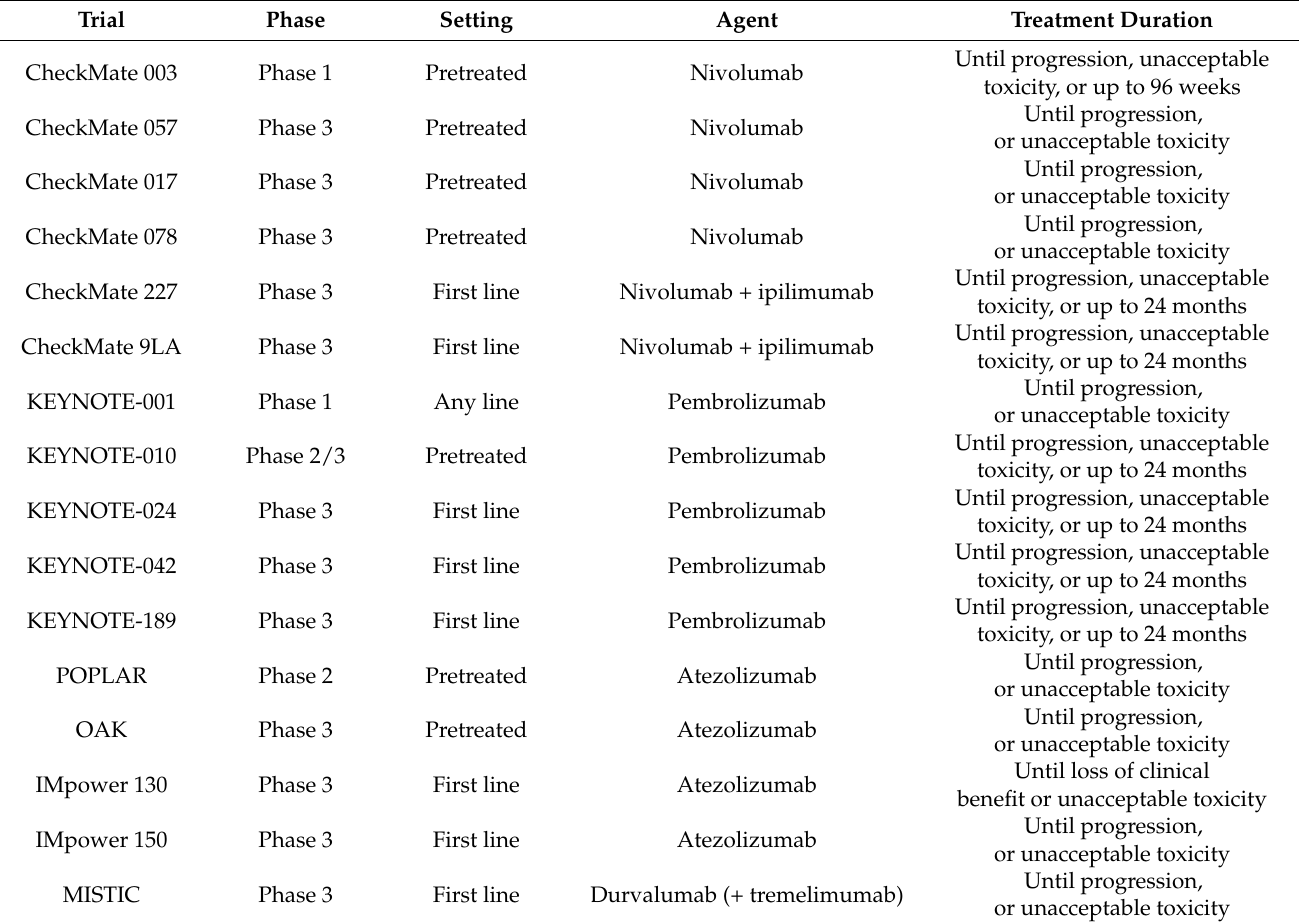
Table 1. Clinical trials reporting data on immunotherapy durations in patients with